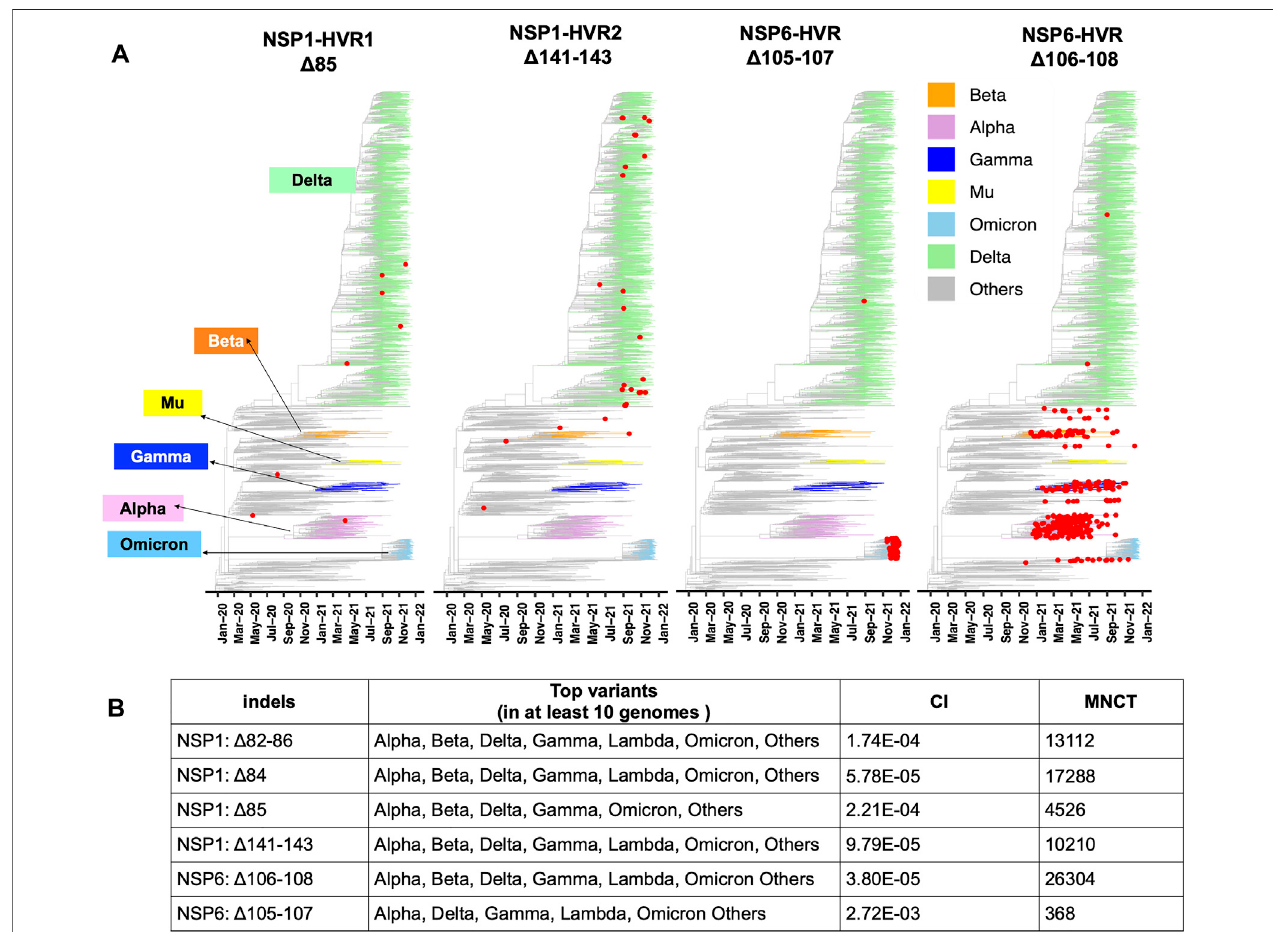
FIGURE 4 | Recurrent Indels in NSP1 and NSP6. (A) Nextstrain time-resolved tree, which includes 3475 genomes sampled between December 2019 and Dec 27 th , 2021) displays the presence and distribution of the most frequent deletions positioned on NSP1-HVRs and NSP6-HVR as red dots (B) Top SARS-CoV-2 variants harbor the most frequent and potentially recurrent deletions of NSP1 and NSP6. Minimum Number of Changes on Tree (MNCT) and Consistency Index (CI) calculated using HomoplasyFinder based on GISAID global tree (4,701,022 SARS-CoV-2 genomes as of January 7 th , 2022).